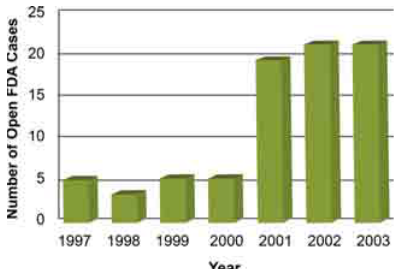
Figure 1. The Number of Investigations of Possible Counterfeit Drugs by the FDA Has Been Rising (Figure: Margaret Shear, Public Library of Science, adapted from